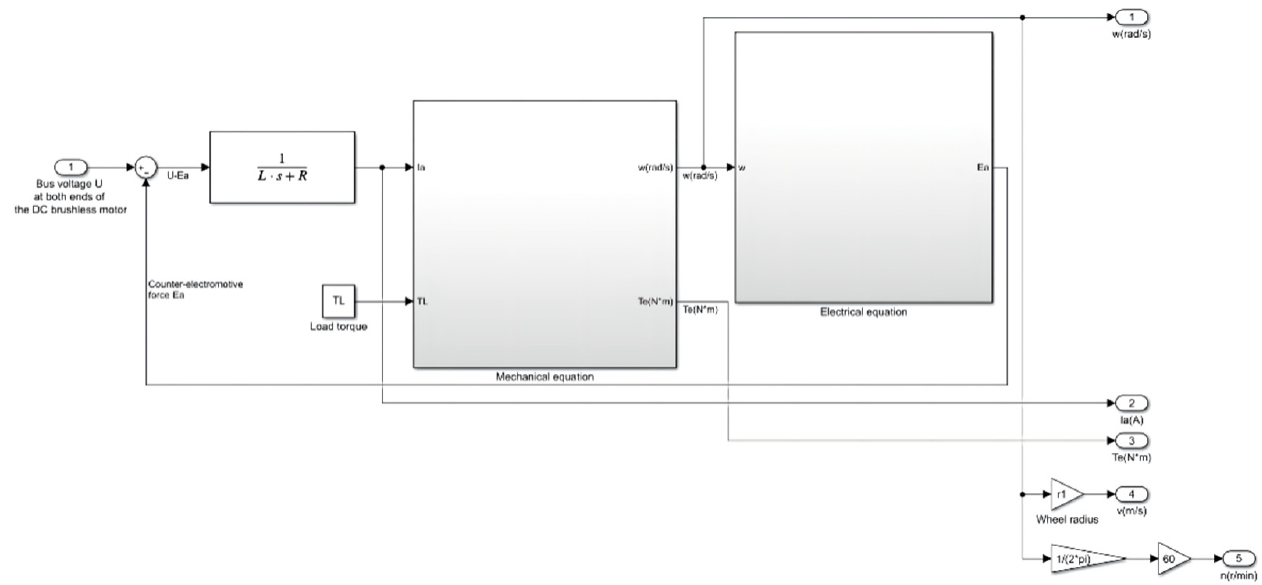
Figure 4. Travel drive system model.